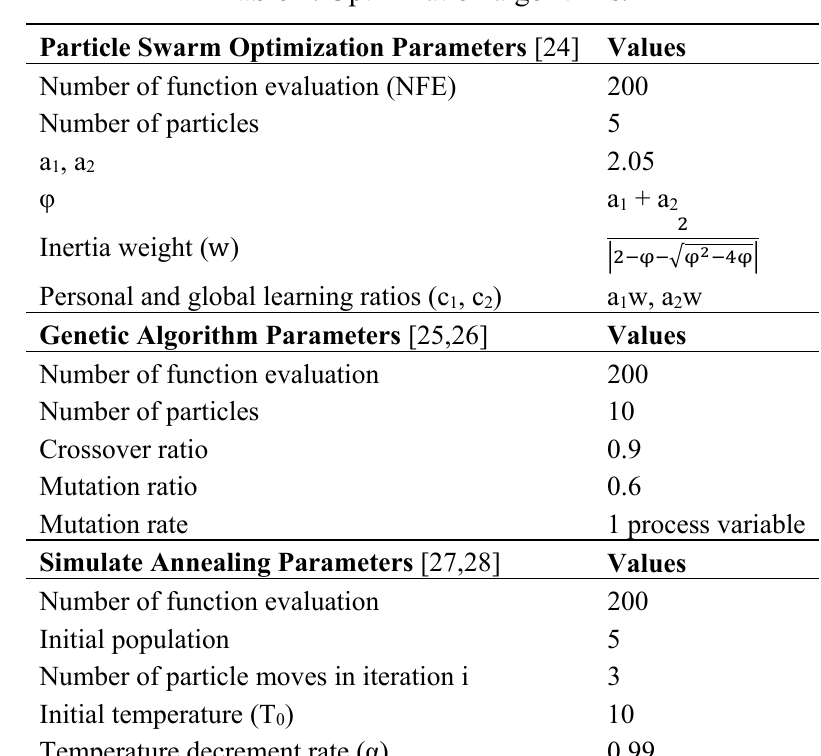
Table 2. Optimization